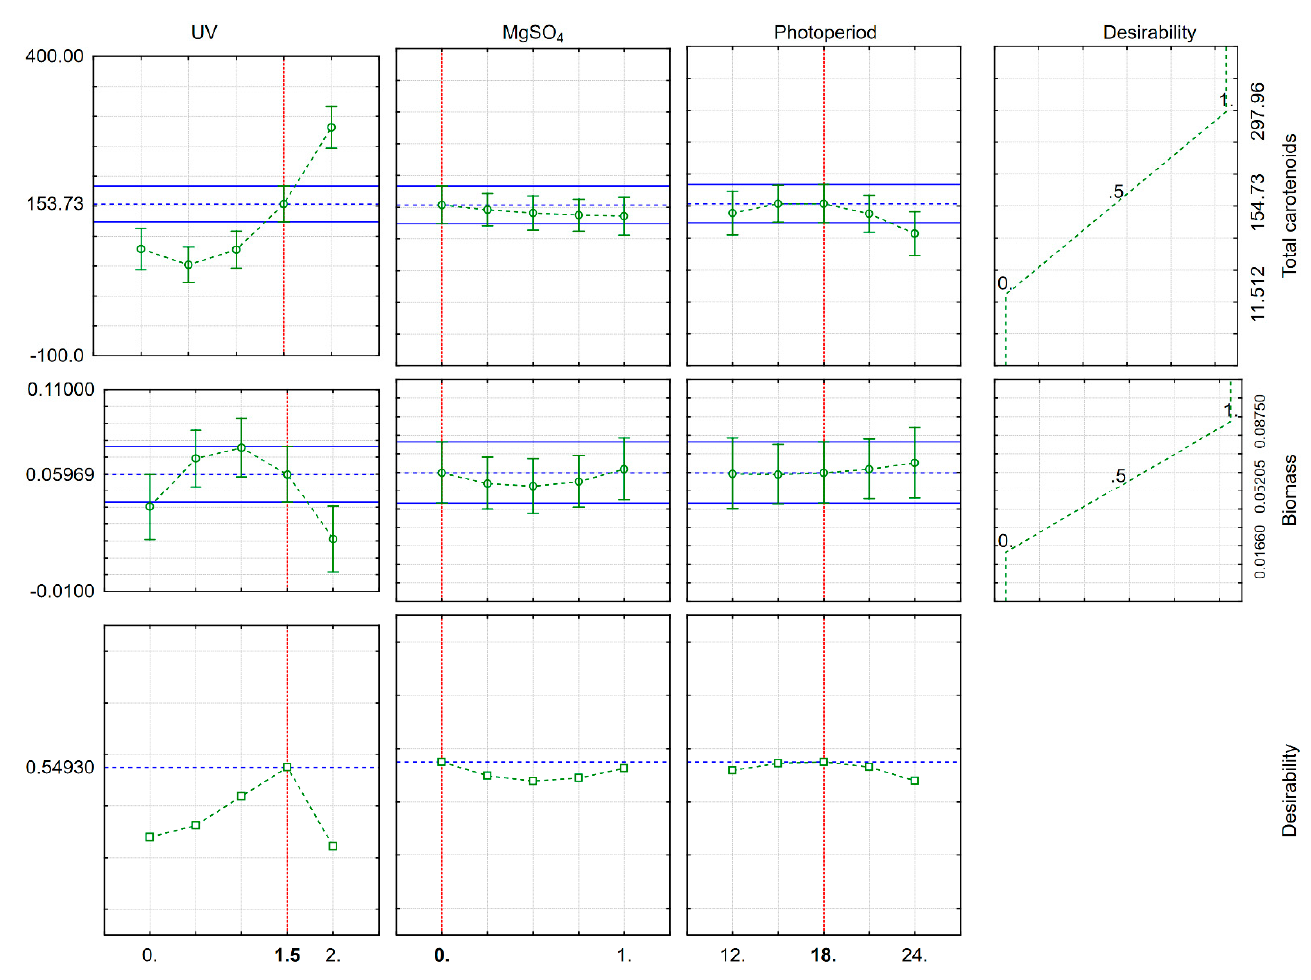
Figure 2. Desirability plot highlighting the optimal cellular stress parameters to maximize biomass and carotenoid pro- duction.